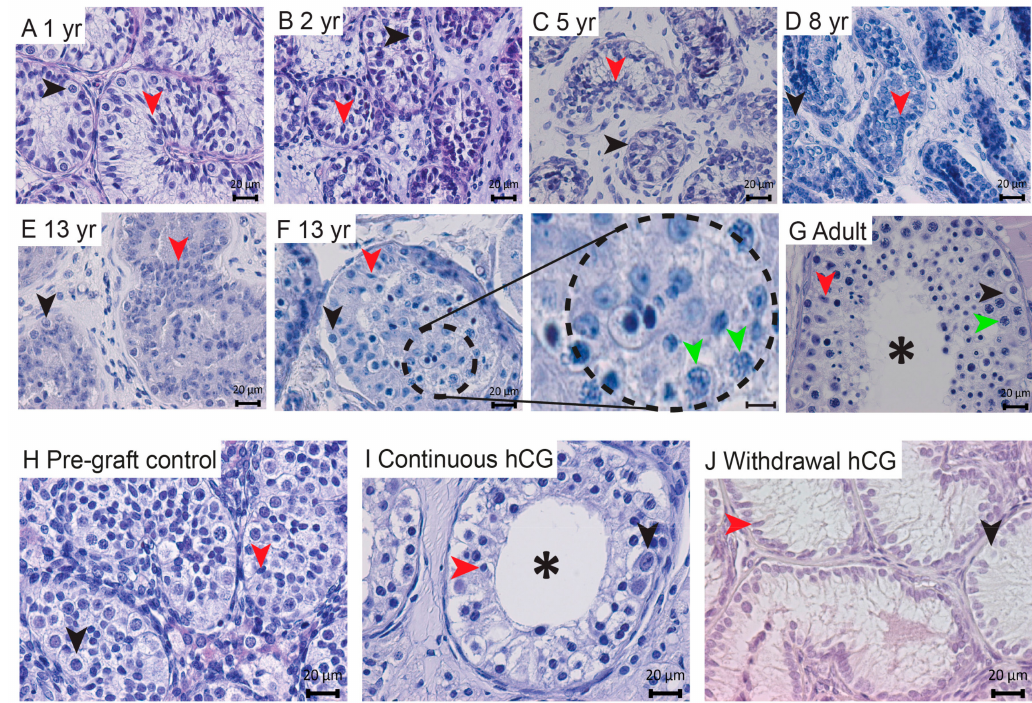
Figure 2. Continuous hCG stimulation induces lumen development in long-term human fetal testis xenografts. ( A – G ) The histological evaluation of human testis tissue architecture across development. ( F ) The right panel shows a higher magnification of the encircled area in the left panel. ( H , J ) No signs of lumen development were observed in any of the pre-graft control tissues (14 GW) or the withdrawal hCG group (7 months hCG followed by 5 months withdrawal hCG). ( I ) Continuous hCG exposure induced lumen formation in all long-term xenografts (9 months). The images in ( I , J ) are representative of n = 27 and n = 4, respectively. The asterisks depict seminiferous tubules with a developed lumen. Red arrowheads denote Sertoli cells. The black arrowheads indicate immature germ cells (spermatogonia). The green arrowheads show meiotic cells (spermatocytes). yr: years. Scale bar: 20 µ